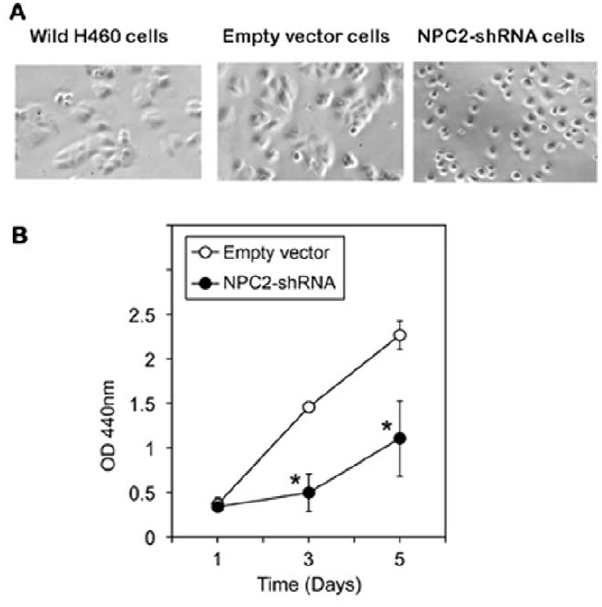
Figure 2. Characterization of three types of cultured H460 cells. Cell morphology: Wild and empty vector cells showed the same cell morphology, whereas cells containing NPC2-shRNA displayed clearly separated individual cells. Cell proliferation activity in NPC2-rich and- depleted H460 cells: Cells (1000 cells/well) were plated into a 96-well plate. Cell proliferation activity on each day was measured by incubating cells with the reagents for 2 hours in a CO2 incubator. The results are mean 6 SD of quadruplicate samples of one of the three experiments. * p , 0.01 when compared with the empty vector cells.